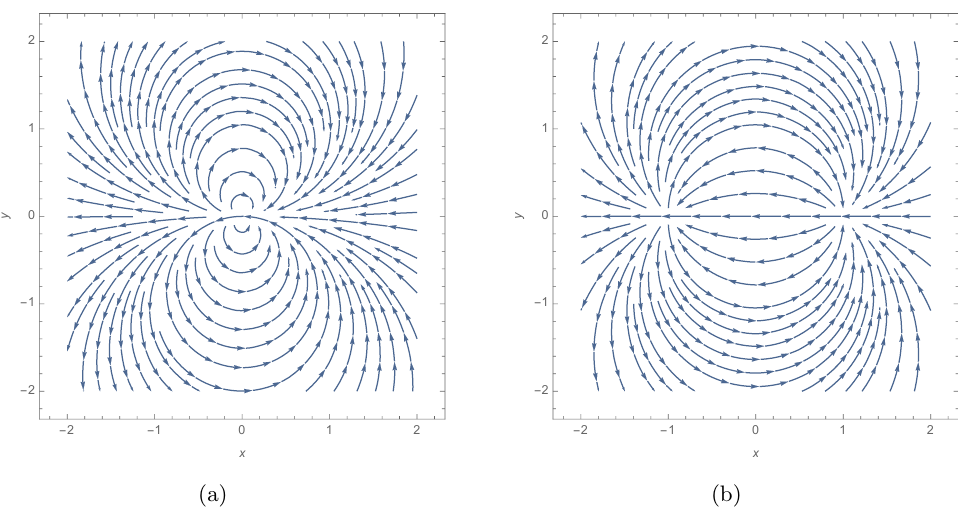
Figure 3 . The real part of the electric (cid:12)eld of the Eguchi-Hanson single copy, using Cartesian coordinates in Minkowski signature: (a) for ( t; z ) = (0 ; 0); (b) for ( t; z ) = (1 ; 0). The imaginary part can be obtained by rotating the (cid:12)gures by 90 (cid:14) .